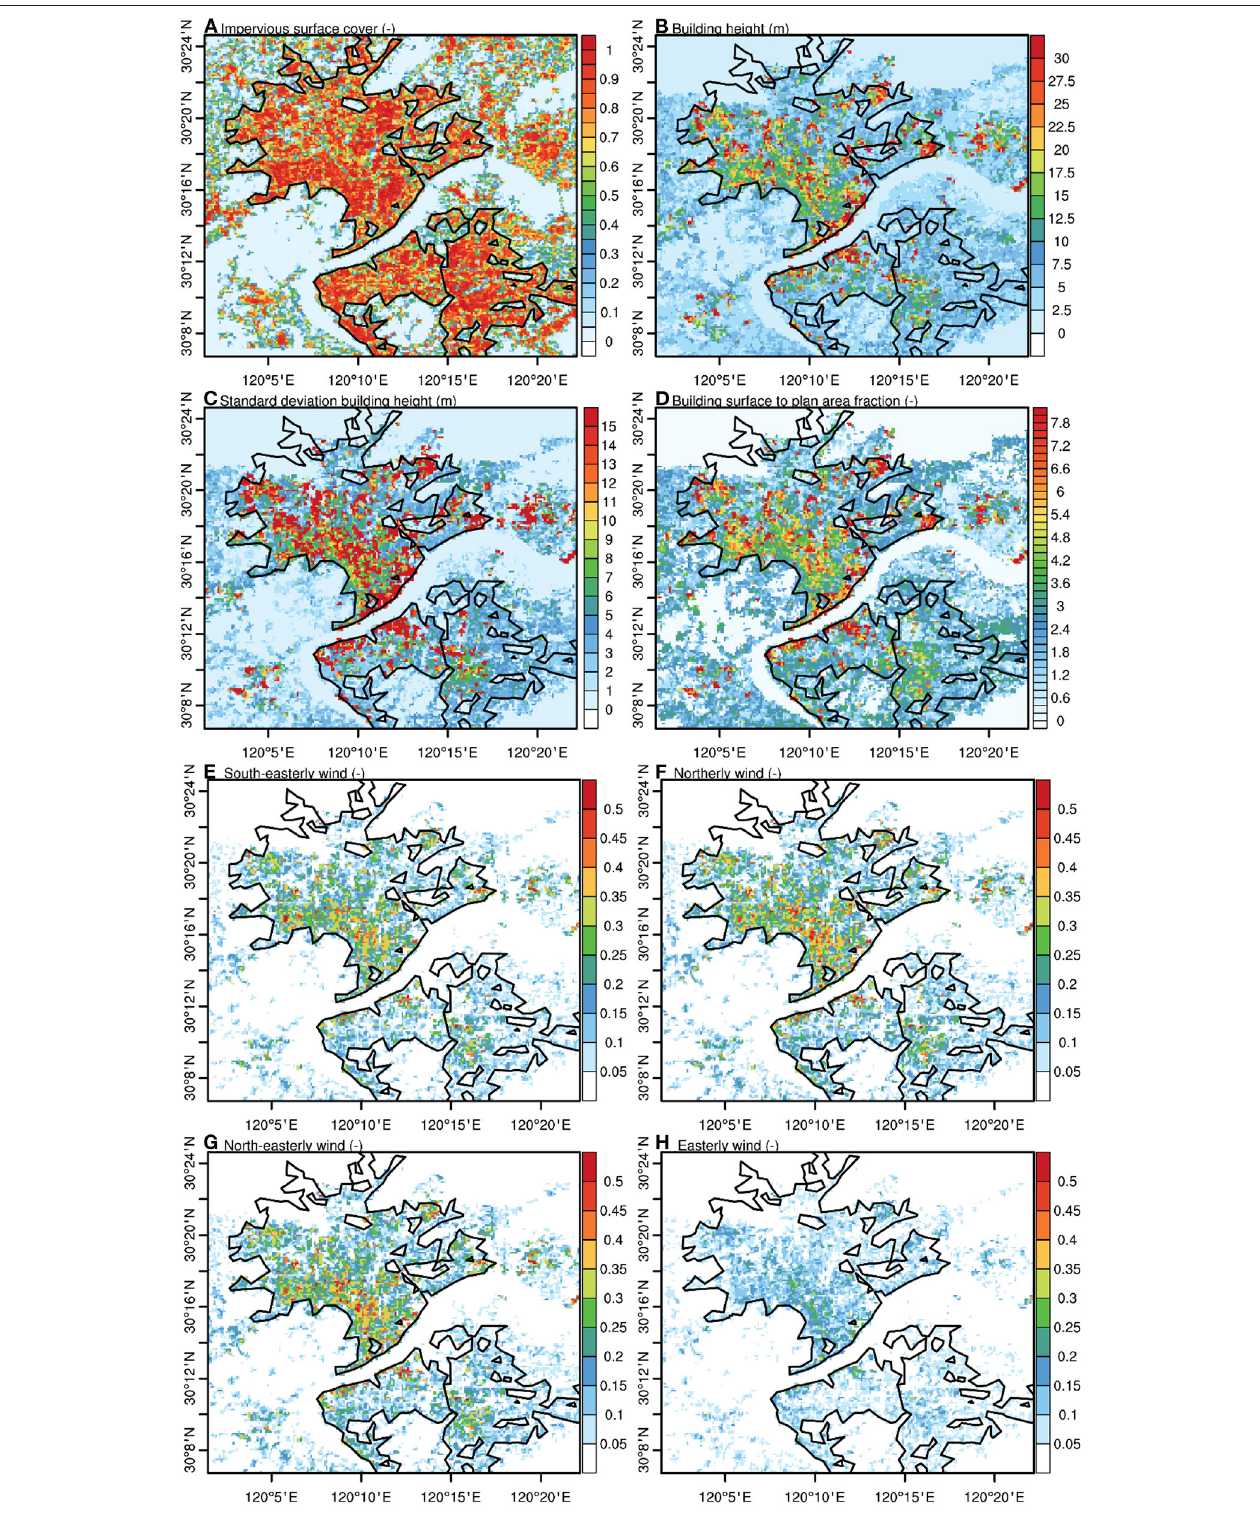
FIGURE 3 | Gridded urban canopy parameters: (A) impervious fraction (unitless); (B) area weighted mean building height (m); (C) standard deviation of building height (m); (D) building surface area to plan area ratio (unitless); (E) southeasterly wind frontal area density (unitless); (F) northerly wind frontal area density (unitless); (G) northeasterly wind frontal area density (unitless); (H) easterly wind frontal area density (unitless).